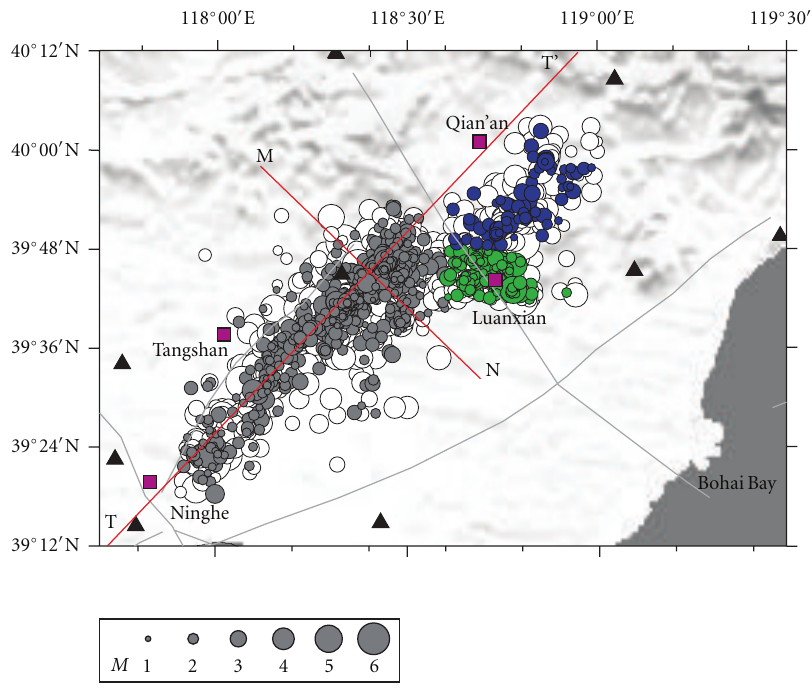
Figure 11: Epicentral distribution of earthquakes before (open circles) and after (solid circles) relocation using the tomoDD in the Tangshan area.